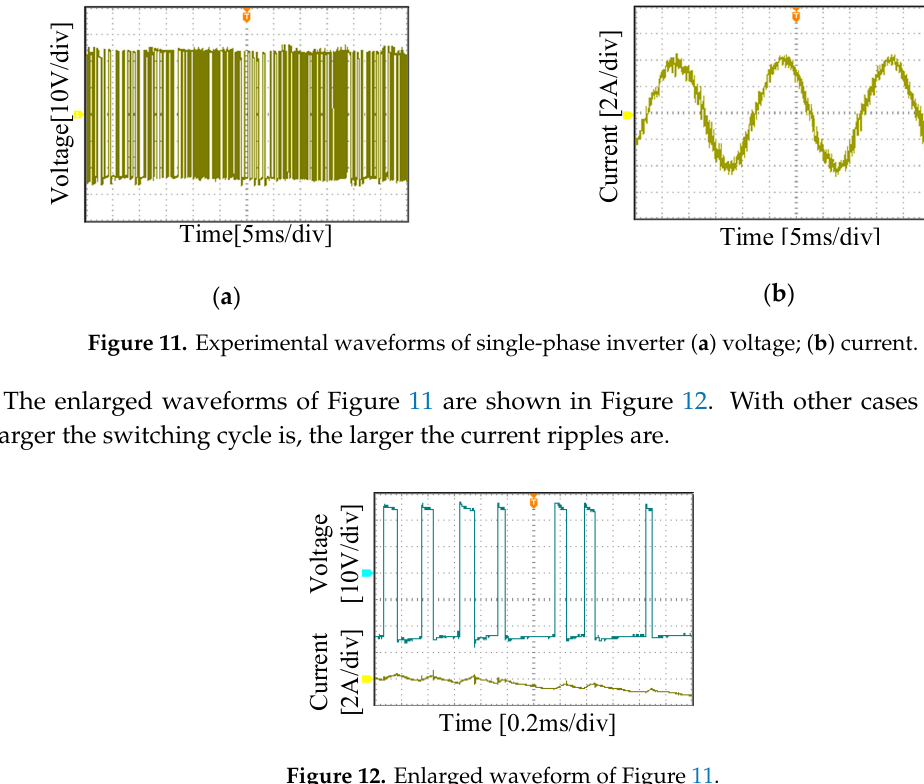
Figure 12. Enlarged waveform of Figure 11.